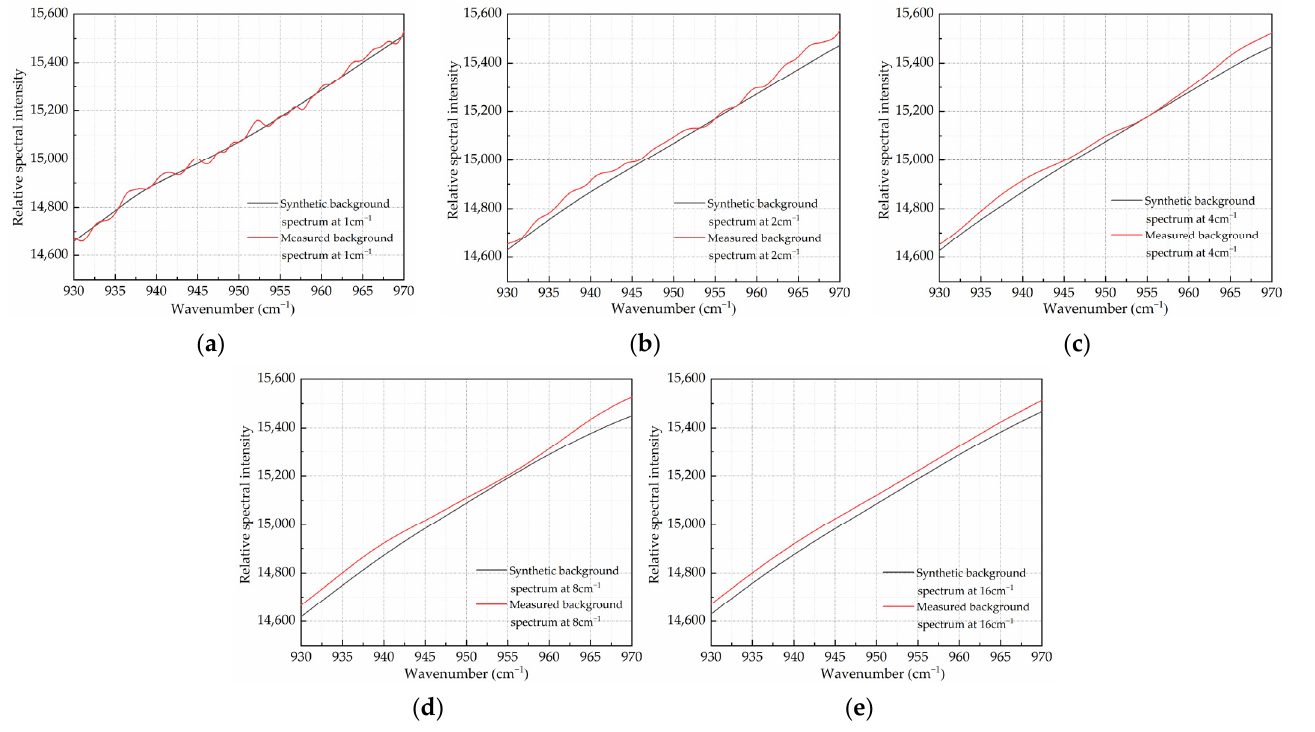
Figure 4. ( a ) the synthetic background spectrum of C 2 H 4 at 1 cm − 1 when the number of smoothening points is 5 and the number of filtering times is 700; ( b ) the synthetic background spectrum of C 2 H 4 at 2 cm − 1 when the number of smoothening points is 5 and the number of filtering times is 700; ( c ) the synthetic background spectrum of C 2 H 4 at 4 cm − 1 when the number of smoothening points is 5 and the number of filtering times is 700; ( d ) the synthetic background spectrum of C 2 H 4 at 8 cm − 1 when the number of smoothening points is 5 and the number of filtering times is 700; ( e ) the synthetic background spectrum of C 2 H 4 at 16 cm − 1 when the number of smoothening points is 5 and the